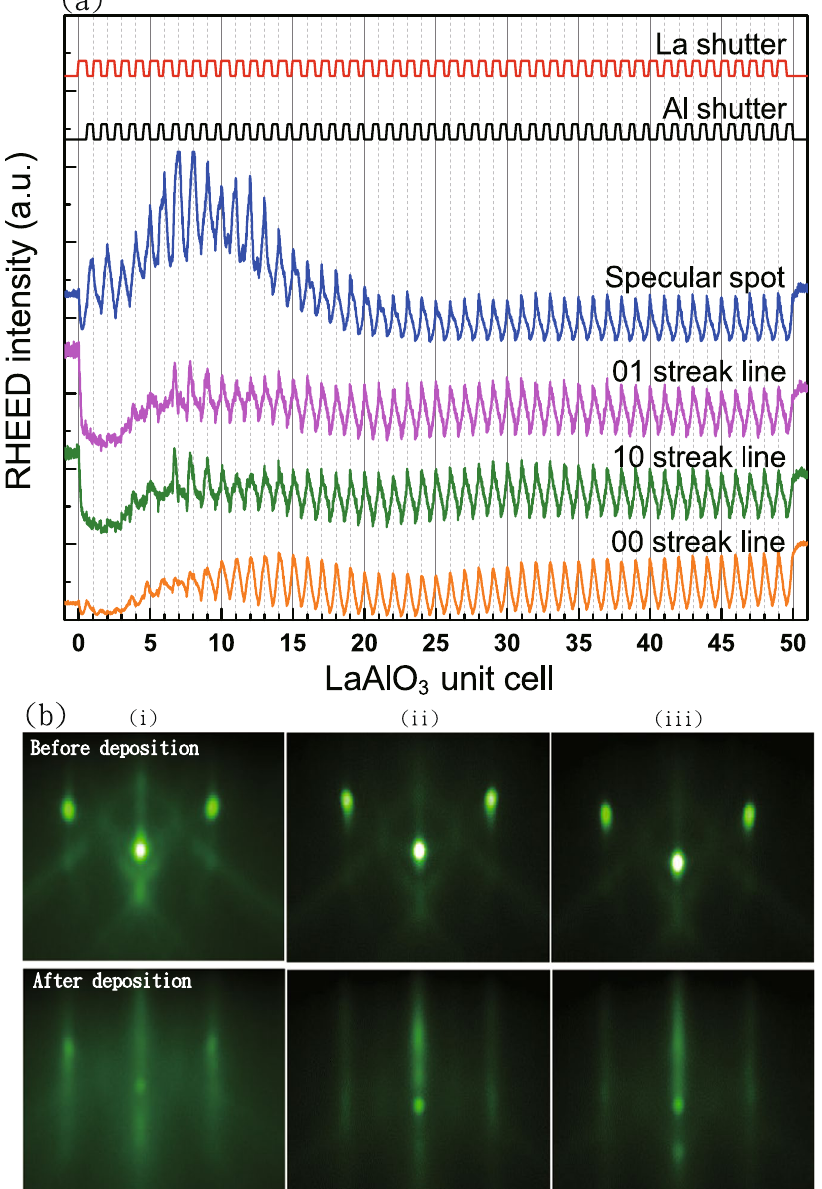
Figure 1. ( a ) RHEED oscillations of a 50-uc thin LAO film grown on the STO substrate. ( b ) The RHEED images along the STO[011] azimuth direction before (upper panel) and after (lower panel) the growth of LAO films with La/Al ratios = 1.1 (i), 1.0 (ii), and 0.9 (iii). The 3D spot-like feature evolves into 2D streak lines after the LAO film growth, indicating an atomic-scale uniformity of the grown ultra-thin LAO films without island